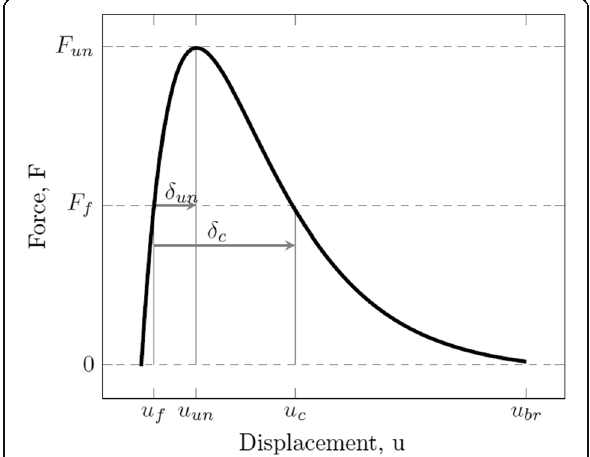
Fig. 2 Strain diagram for contact bond (scheme): F f is the value of “ applied ” force; u f is the deviation of an atom from the equilibrium position due to mechanical load; F un and u un are the force and displacement of a contact bond instability, respectively; δ un is the fluctuation of the bond instability; u c and δ c are the critical displacement and critical fluctuation, respectively; u br is the displacement of bond